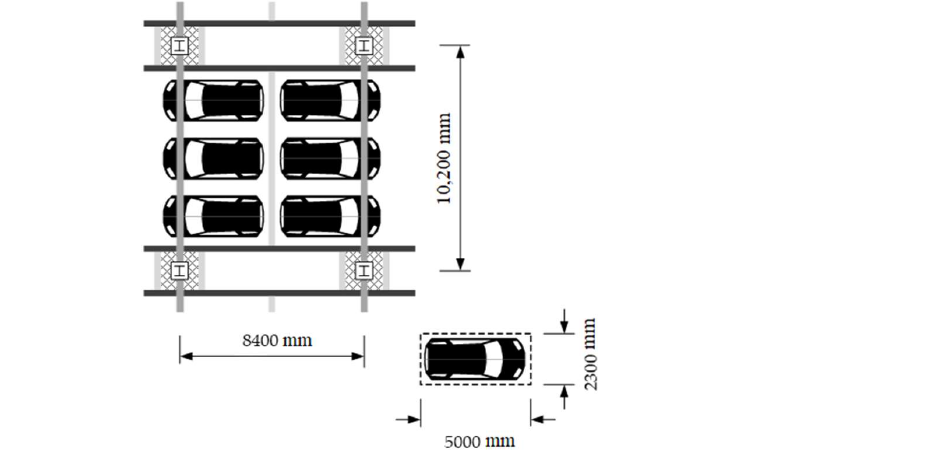
Figure 4. A representative floor plan of underground structures considering the column spacing for parking lots. Table 1. Live loads according to the usages of the underground space [44].